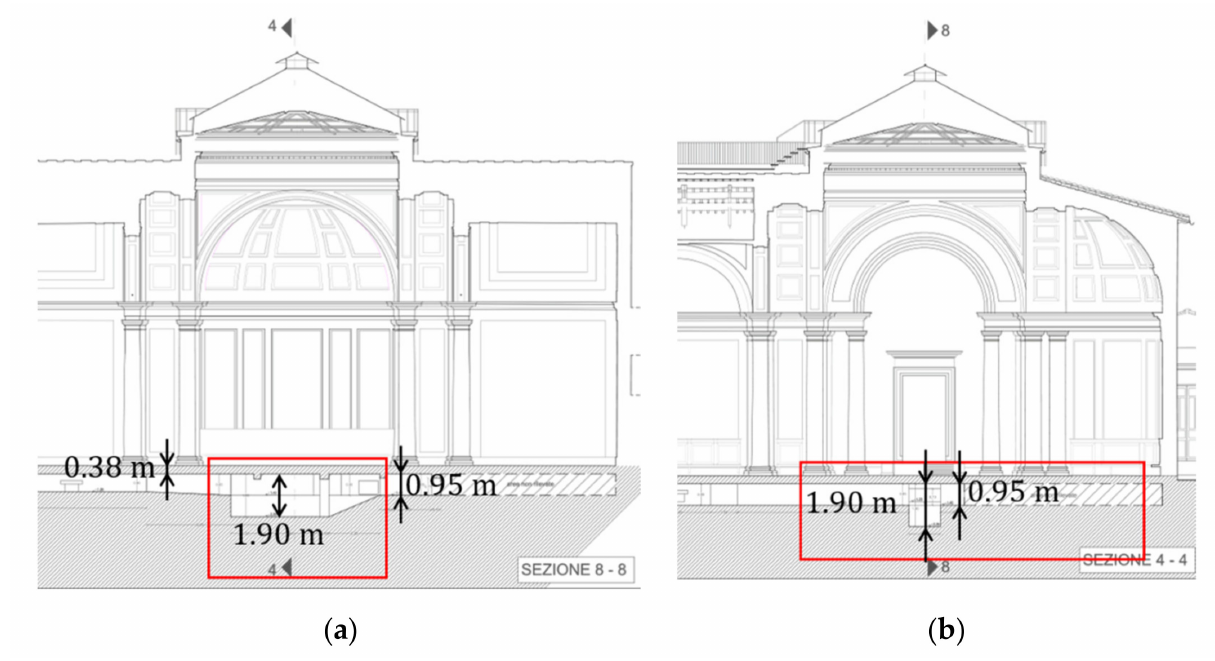
Figure 3. Vertical sections of the Accademia Gallery: ( a ) section 8 − 8; ( b ) section 4 −